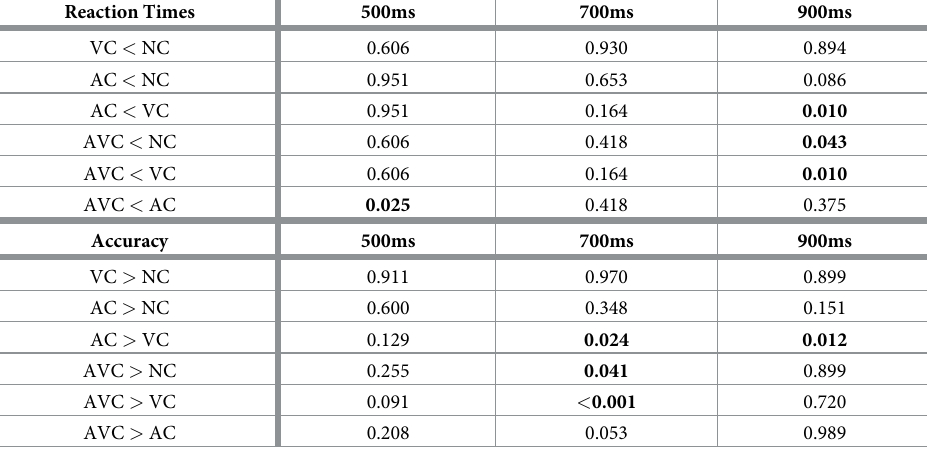
Table 3. Benjamini-Hochberg adjusted p-values from paired one-sided t-tests for pre-stimulus differences within each SOA, for reaction times (RTs) and accuracy ( α = 0.05). Statistically significant values are in bold. Reaction